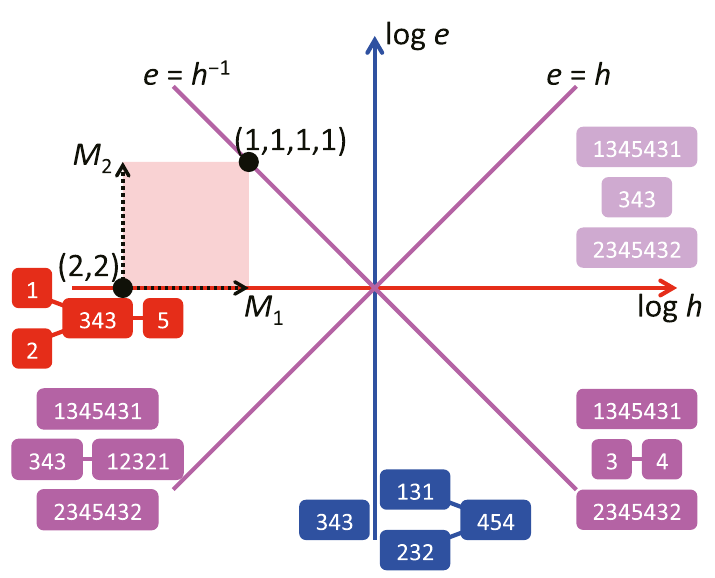
Figure 5 . The patterns of the symmetry breaking in the (log h; log e ) plane